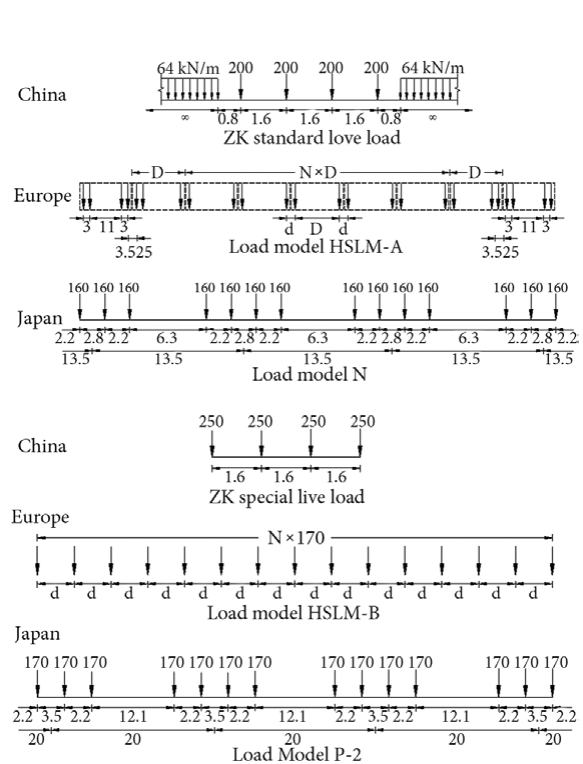
Fig. 4. Main HSR live load models in the world, in